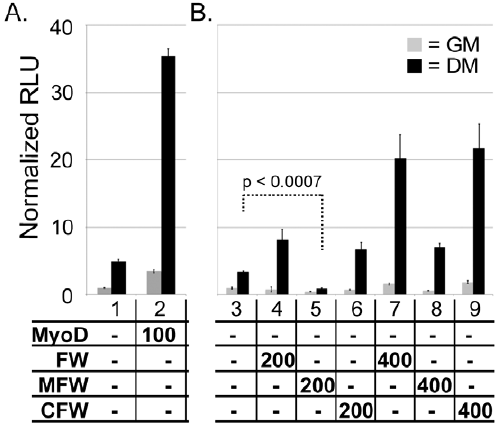
Figure 5. Wdr68 and derivatives modulate transcriptional activation of a myog promoter-reporter construct in C2C12 cells. C2C12 cells transfected with myog-luciferase and SV40-renilla reporters. Grey columns are cells in growth medium (GM). Black columns are cells in differentiation medium (DM). The y-axis units are the same for parts A and B. A) Column pairs 1) empty pCS2 + expression vector control showing endogenous basal levels of reporter induction, 2) 100 ng MyoD further enhances reporter activity 7-fold above control. B) Column pairs 3) basal control, 4) 200 ng FlagWdr68 (FW) further enhances reporter activity 2.4-fold above control, 5) 200 ng Mad- FlagWdr68 (MFW) represses reporter activity to 27% of control, 6) 200 ng CebpFlagWdr68 (CFW) further enhances reporter activity